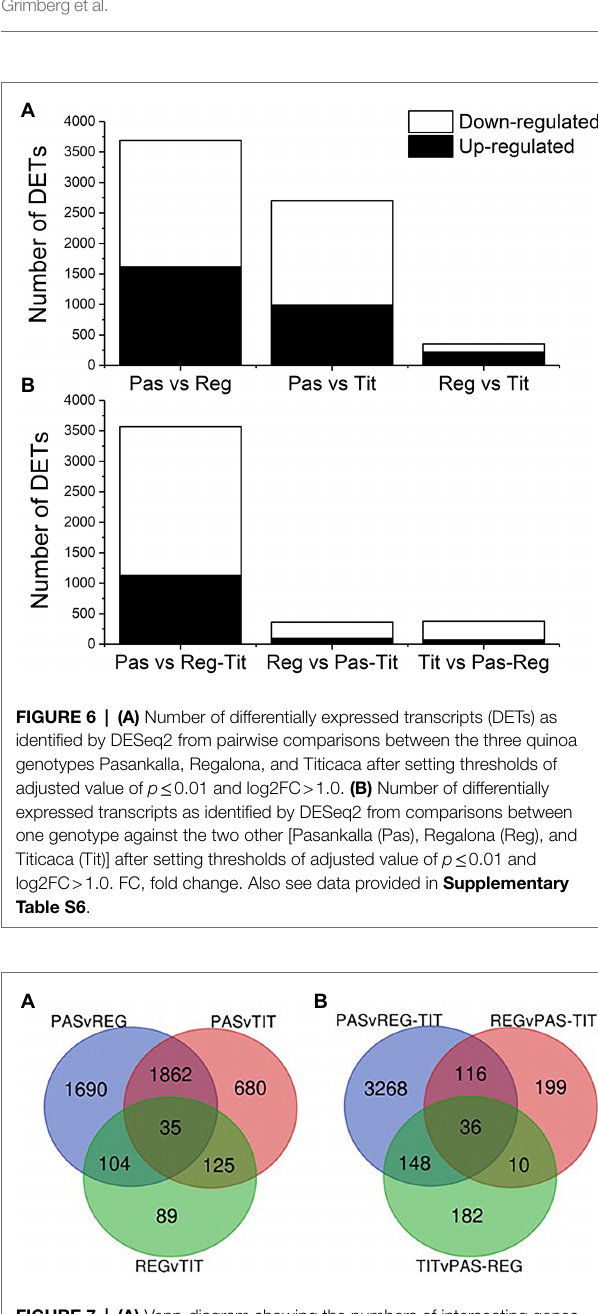
FIGURE 7 | (A) Venn-diagram showing the numbers of intersecting genes from the DETs identified from pairwise comparisons of the three genotypes Pasankalla (Pas), Regalona (Reg), and Titicaca (Tit). Adjusted value of p ≤ 0.01 and log2FC > 1.0. (B) Venn-diagram showing the numbers of intersecting genes from the DETs identified from comparisons of one genotype against the other two genotypes of quinoa. Adjusted value of p ≤ 0.01 and log2FC > 1.0. FC, fold change. Also see data provided in Supplementary Table S6